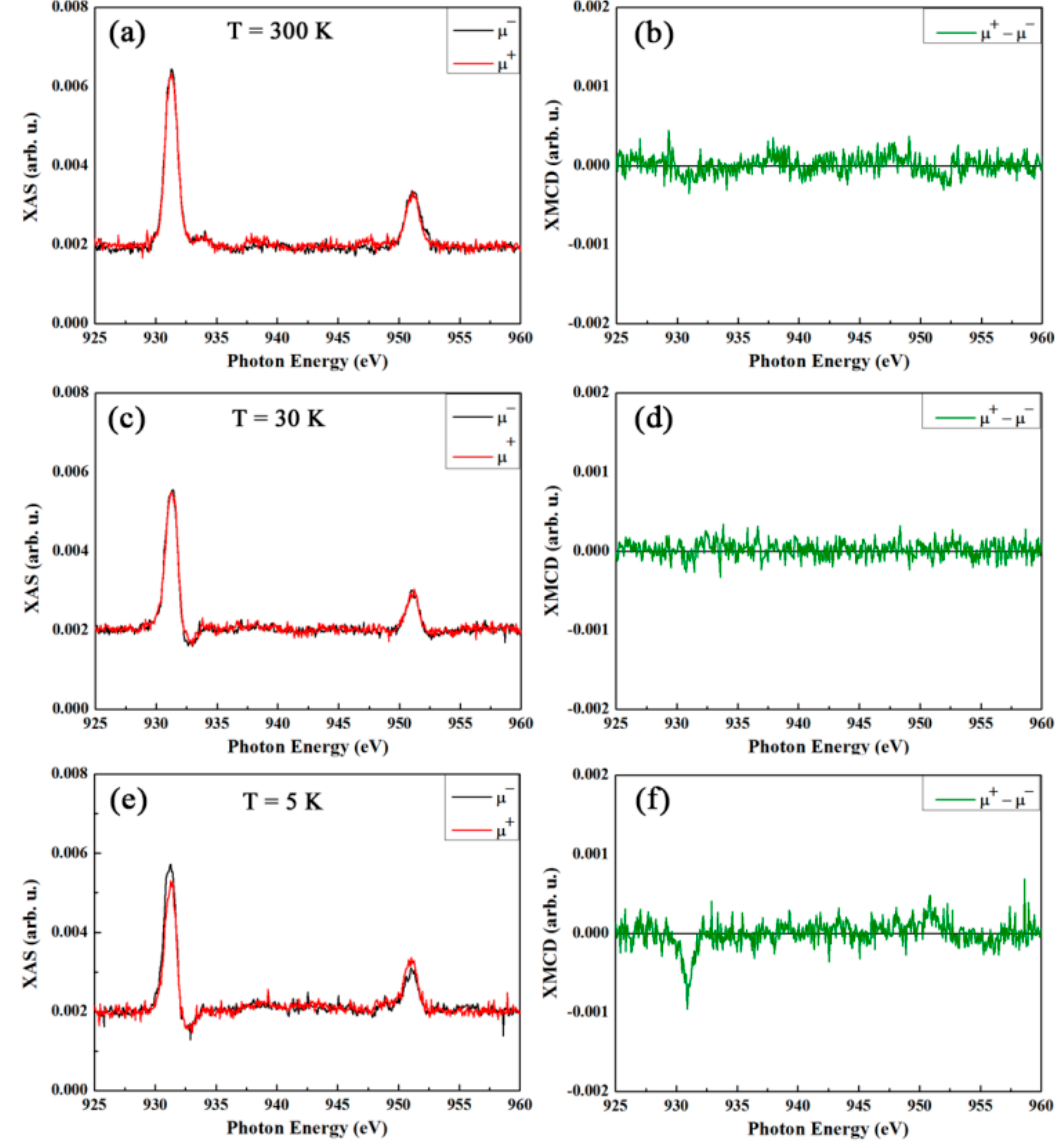
Figure 8. Cu L 3,2 edge XAS spectra of the powders doped with 7 at.% Cu, measured in total electron yield mode for right ( µ + ) and left ( µ − ) circularly polarized light, recorded at 300 ( a ), 30 ( c ) and 5 K ( e ) under an applied magnetic field of 50 kOe. The cooling was done in 50 kOe. ( b , d , f ) are the corresponding XMCD signals (i.e., difference between right and left circularly polarized light).